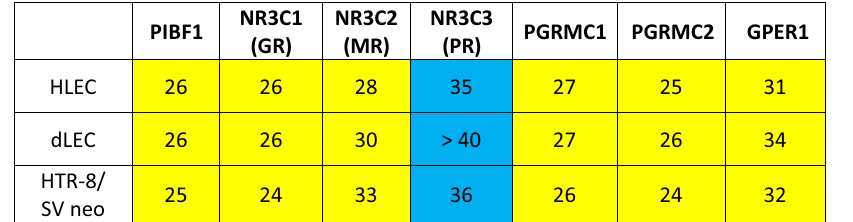
Table 4. Gene expression analysis in HLEC, dLEC and HTR-8/SVneo. mRNA expression of PIBF1, and of steroid hormone receptors in HLEC, dLEC and HTR-8/SV neo. Expression levels are shown as ct values per 12.5 ng cDNA. Yellow: significant expression (ct < 35). Blue: no or very low expression (ct ≥ 35). PIBF1 (progesterone induced blocking factor 1), NR3C1 (glucocorticoid receptor), NR3C2 (mineralocorticoid receptor), NR3C3 (progesterone receptor), PGRMC1 (progesterone receptor membrane component 1), PGRMC2 (progesterone receptor membrane component 2), GPER1 (G protein-coupled estrogen receptor 1). Appropriate positive and negative controls were run.